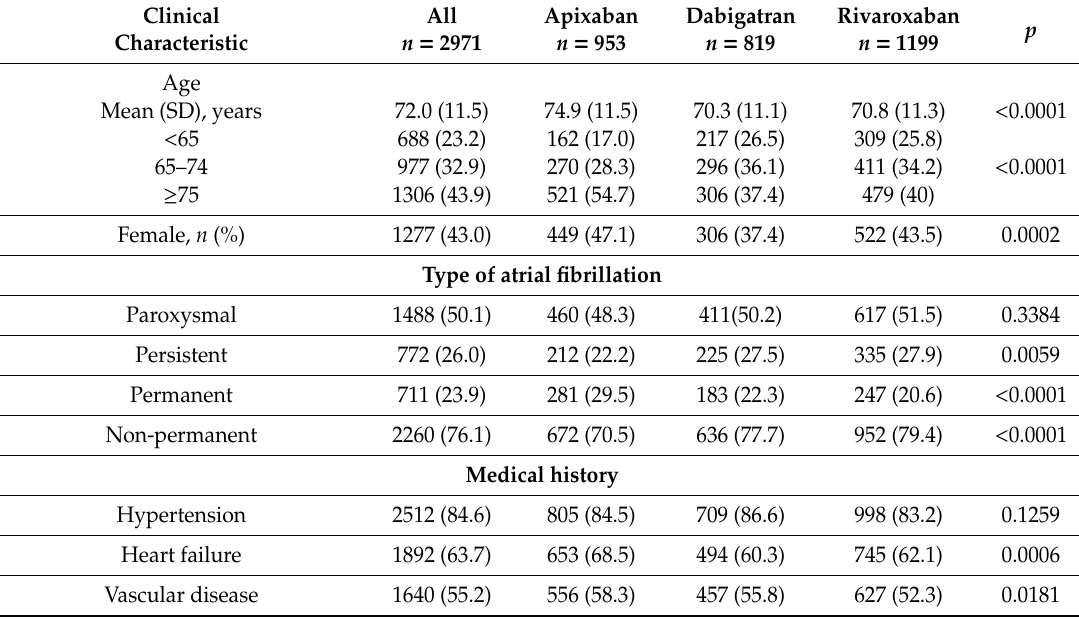
Table 1. Clinical characteristics of patients treated with apixaban, dabigatran, and rivaroxaban.